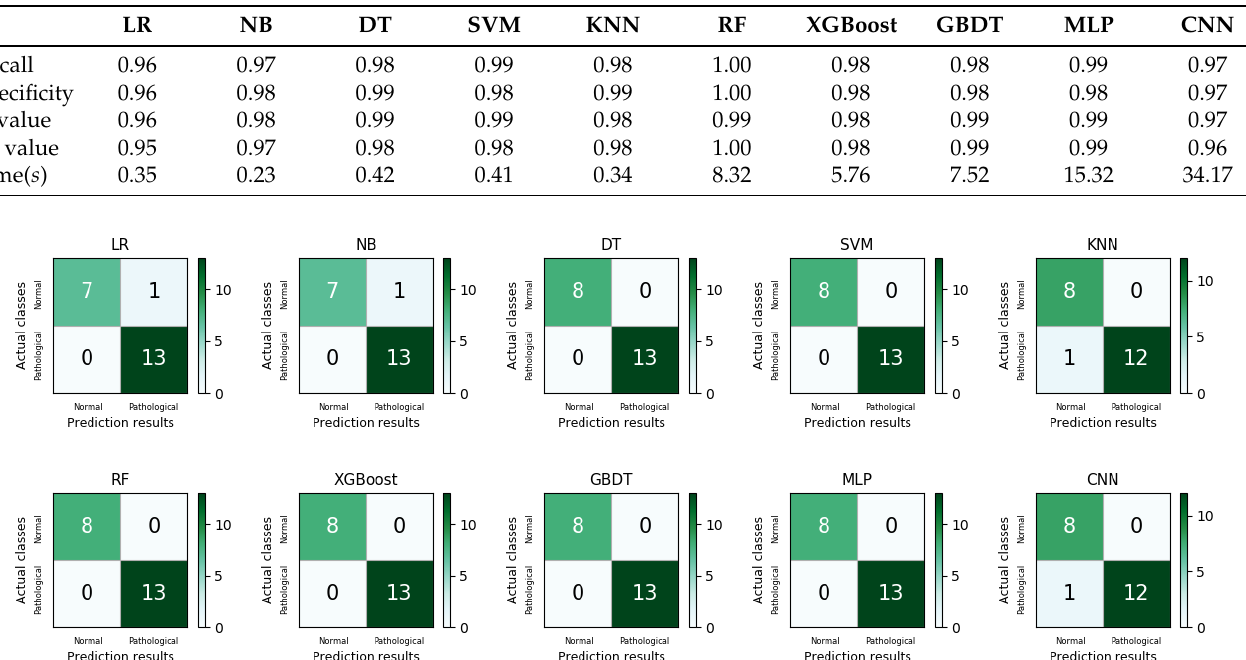
Table 8. Evaluation measures of each machine learning model in the normal and pathological voice class-balanced MEEI dataset.